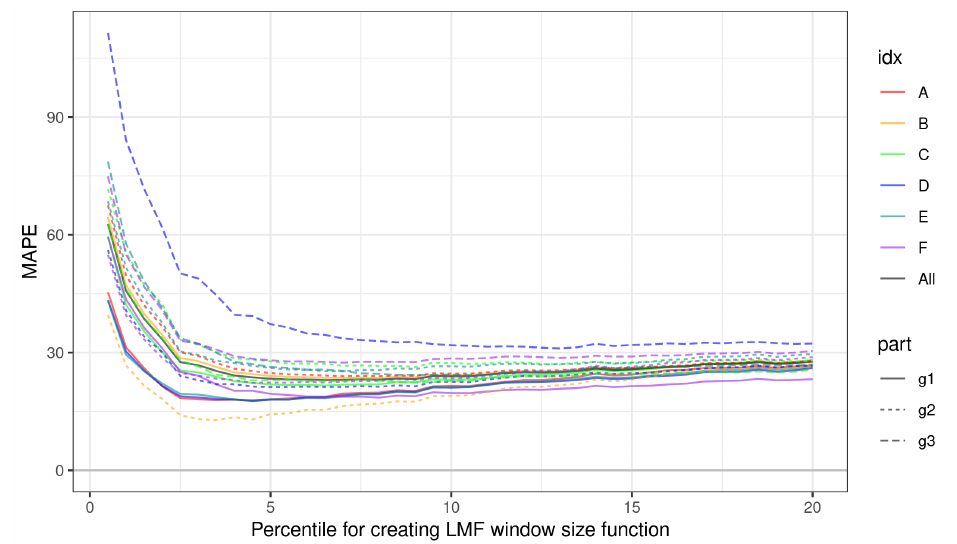
Figure 14. Variability of the MAPE metric for the Local Maximum Filter (LMF) method as a function of crown diameter percentile including sample plot categories and groups (A–F, g1–g3, see Table 2; the ‘All’ group represents the entire set of sample plots).